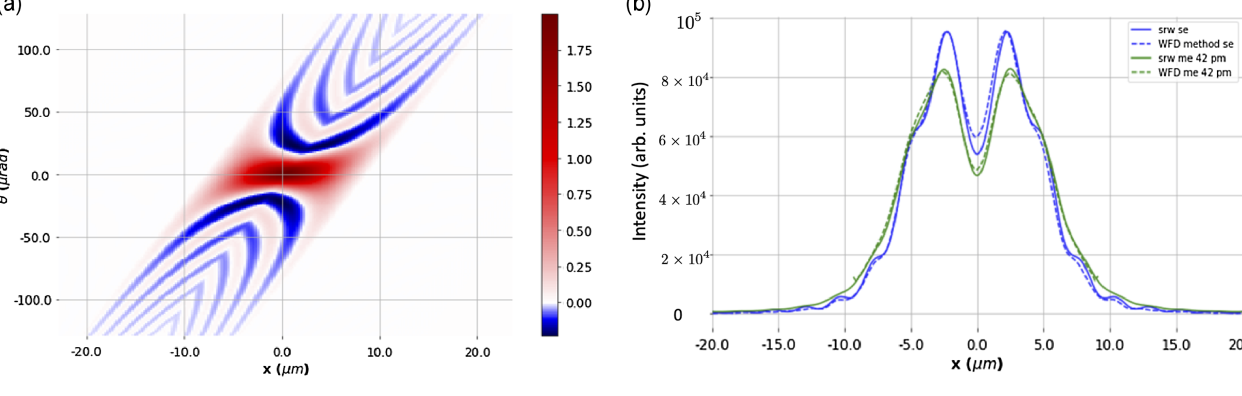
FIG. 10. (a) Fully coherent UR WFD following propagation through single slit aperture and 10 cm drift. (b) Comparison between WFD method and SRW calculation for fully coherent, single electron (se), and partially coherent, multielectron (me), UR spatial